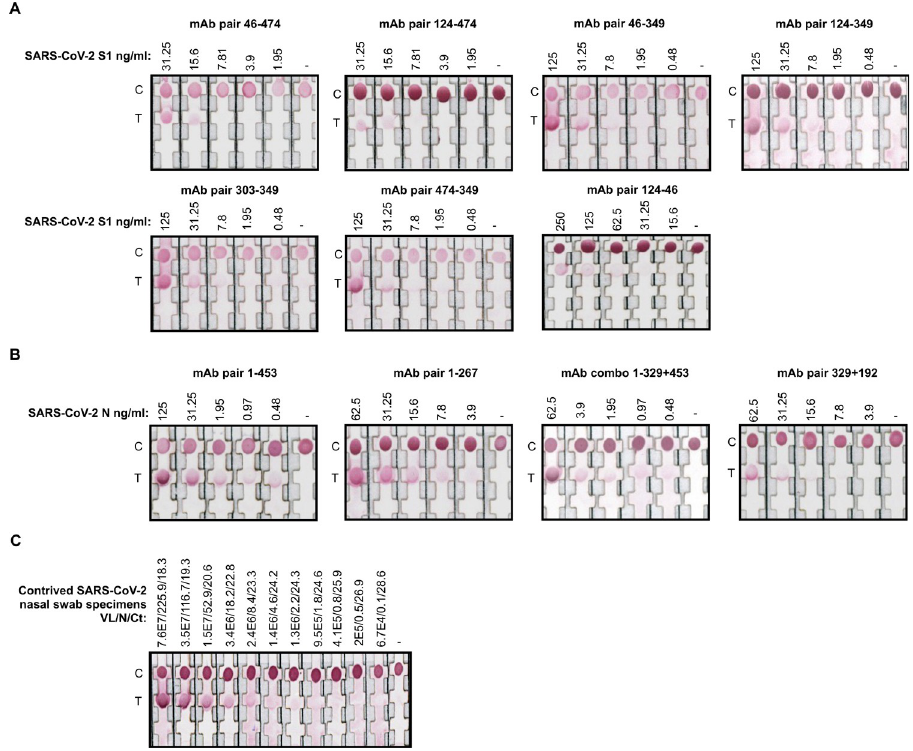
Fig 2. Limit of detections of mAb combinations. Serially diluted recombinant SARS-CoV-2 spike (S1) or nucleoprotein (N) were run on dipsticks with pairs of (A) SARS-CoV-2 S1 mAbs or (B) SARS-CoV-2 N mAbs. mAbs were either conjugated to the nanoparticle or applied onto the nitrocellulose membrane to create a sandwich immunoassay if antigen binding was present. (C) The SARS-CoV-2 N rapid test composed of mAbs 1 and 453 was selected based on its lowest limit of detection to evaluate performance using a panel of contrived SARS-CoV-2 nasal swab specimens. Nasal swab specimens with known viral loads (VL), nucleocapsid (N) protein concentrations, and cycle threshold (Ct) values were allowed to react with the rapid test for 15 minutes. C, control. T,